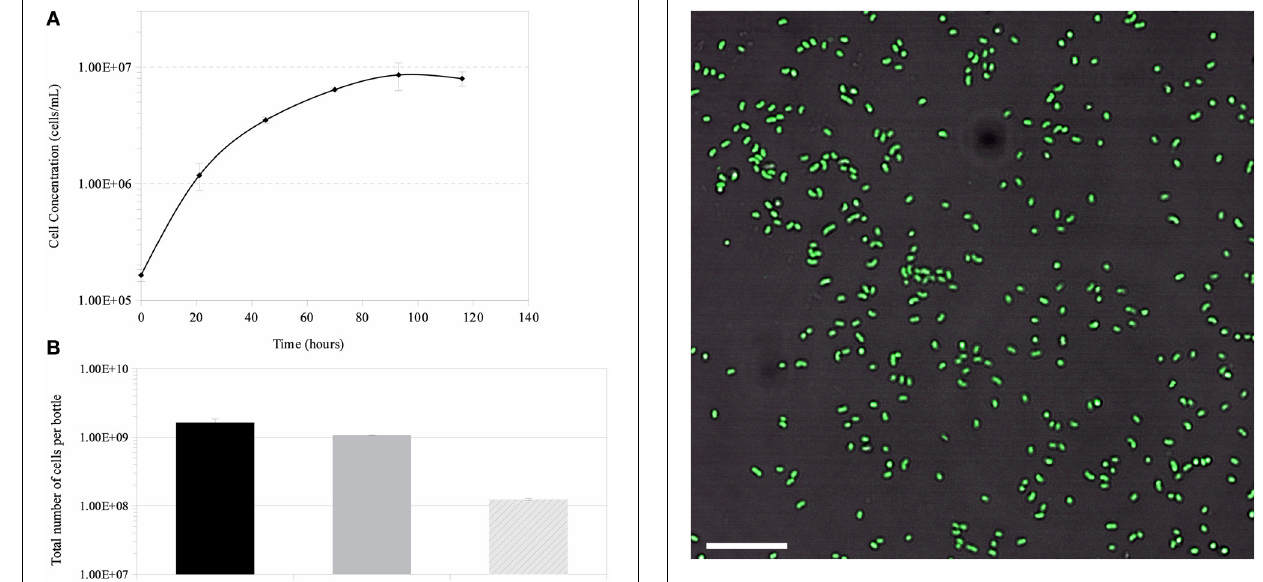
FIGURE 3 | Enrichment of cells without stalks after the sample goes through the cell-separation method (bar = 10 µ